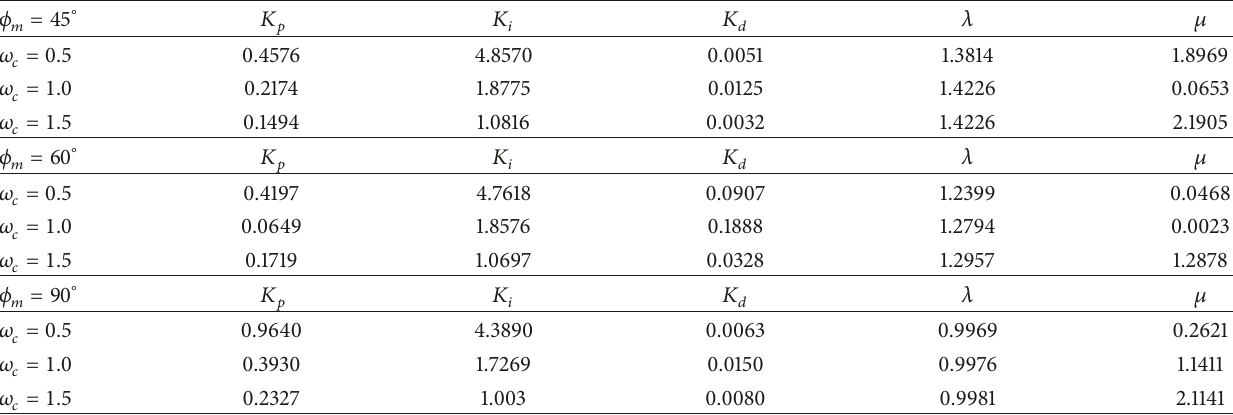
Table 1: Controller parameters of 𝑃 1 (𝑠) .